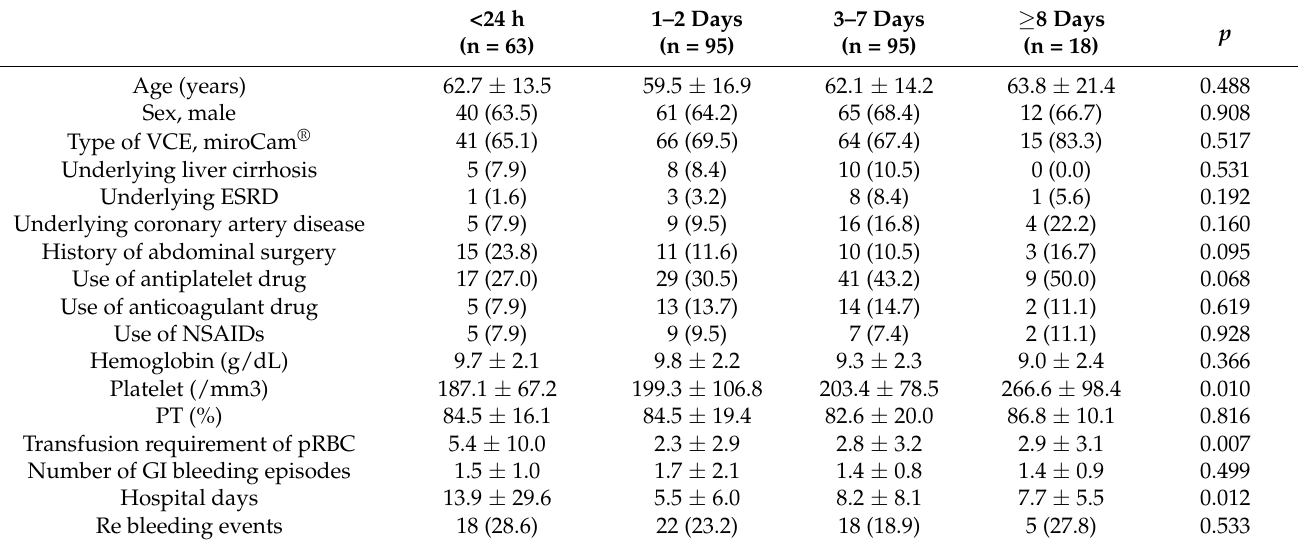
Table 2. Baseline characteristics of enrolled patients according to timing of video capsule